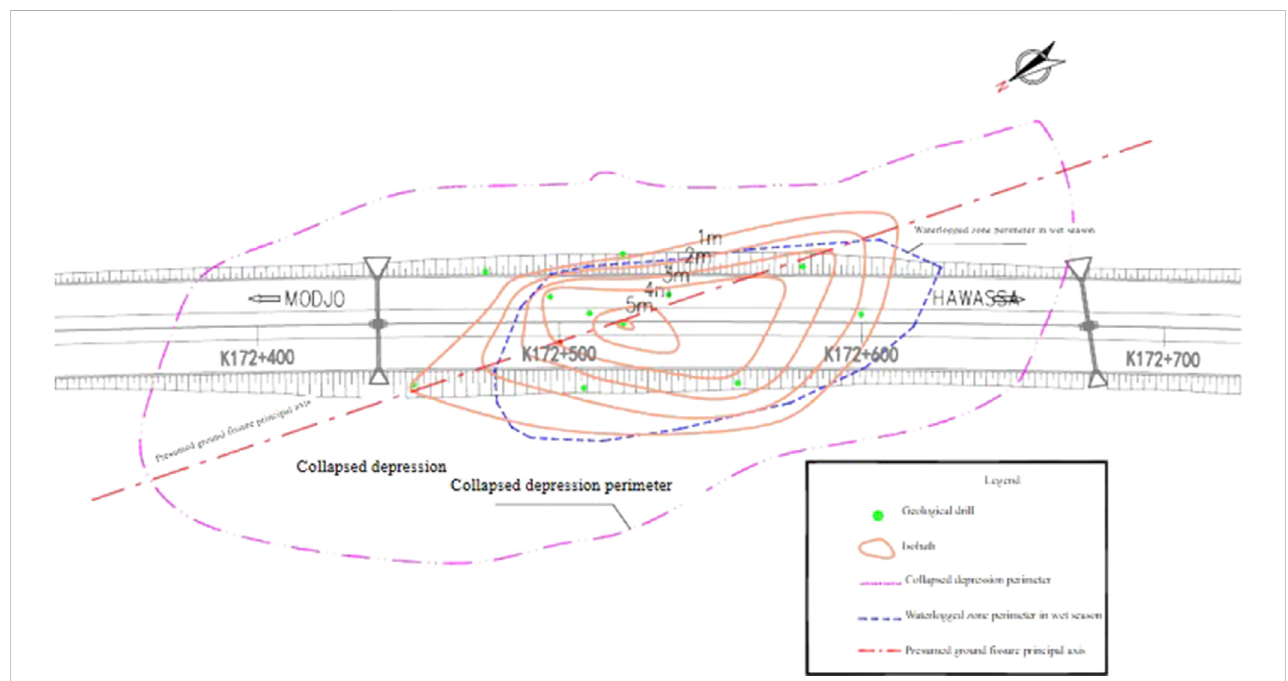
FIGURE 15 Isobath map of the upper clay layer of the collapsed depression in the K165+700~K166+450 section.